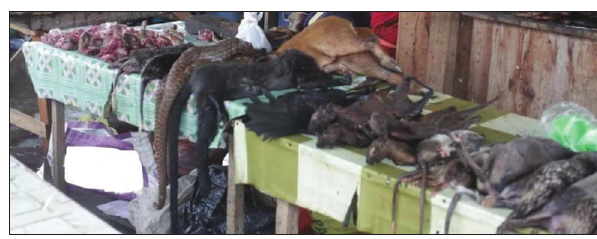
Figure-1: Different animals sold in a wet market [Source: